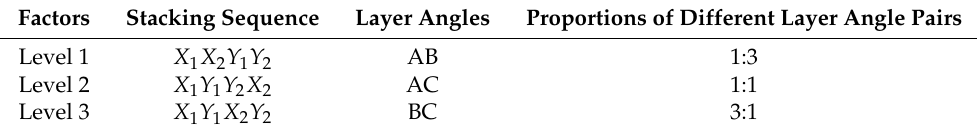
Table 4. Factors and levels of the orthogonal test.